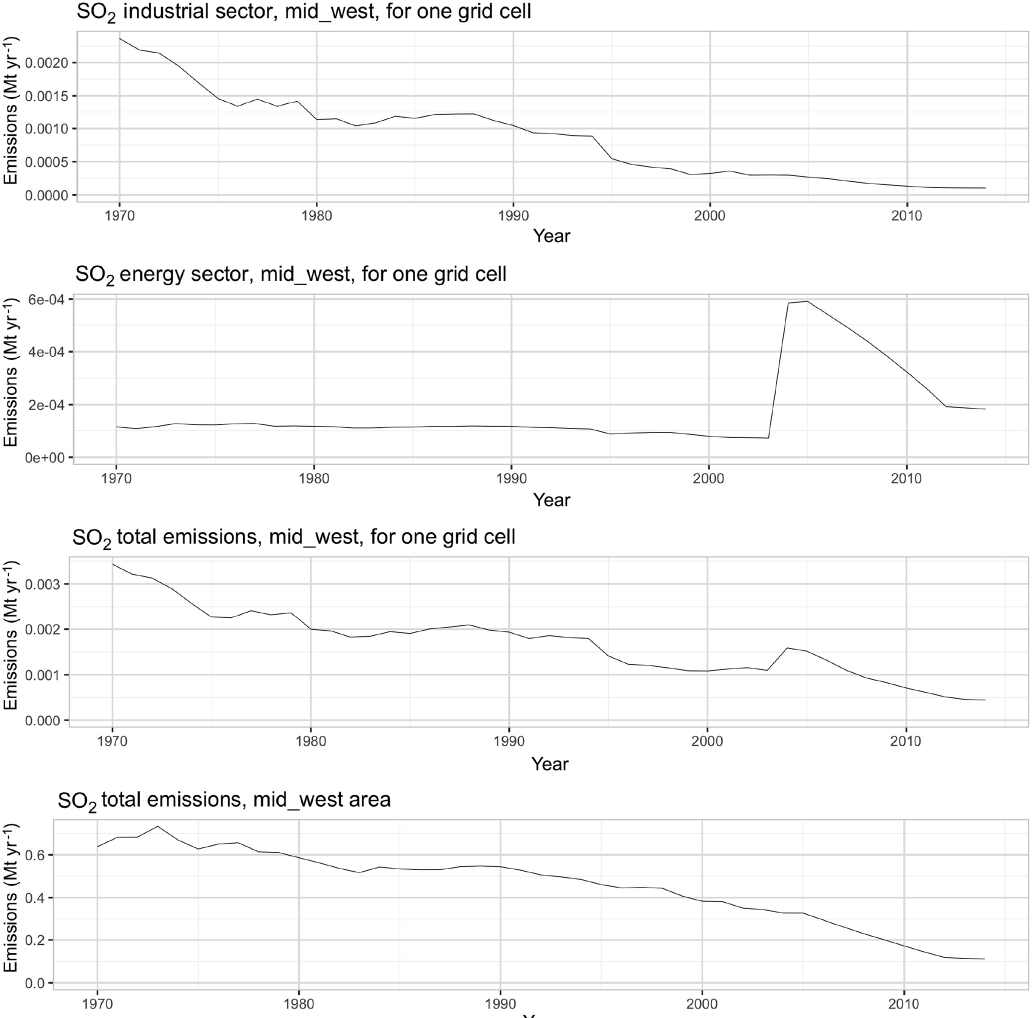
Figure 8. (a) Time series plot for the industrial gridding sector for a single 0.5 ◦ cell in the US midwest (lat, long: 41.25, − 87 . 75). (b) Time series plot for the energy sector for the same grid cell. (c) Time series plot for total anthropogenic emissions for the same grid cell. (d) Time series plot for total anthropogenic emissions summed over 16 grid cells including the cell depicted in (a) – (c)